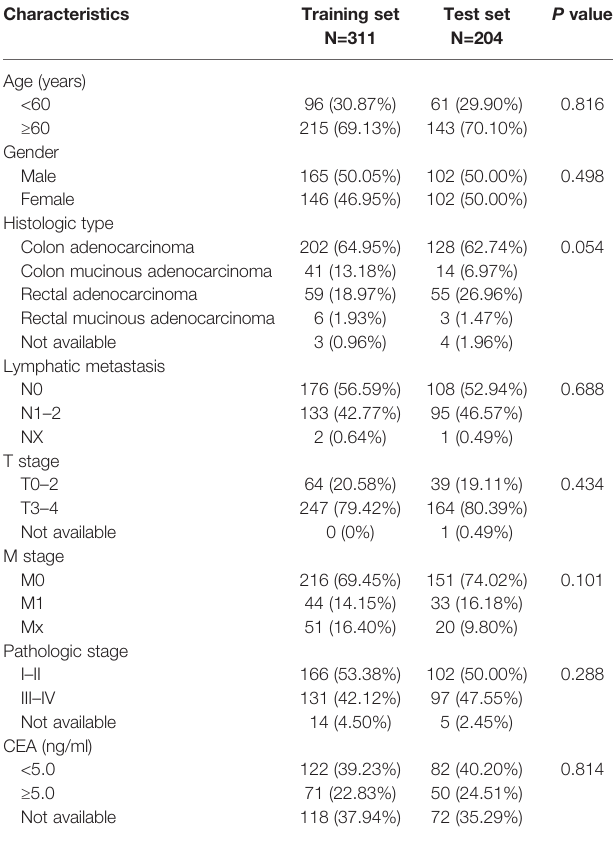
TABLE 2 | Clinicopathological factors of patients with colorectal cancer (CRC) in the the Cancer Genome Atlas (TCGA) dataset.